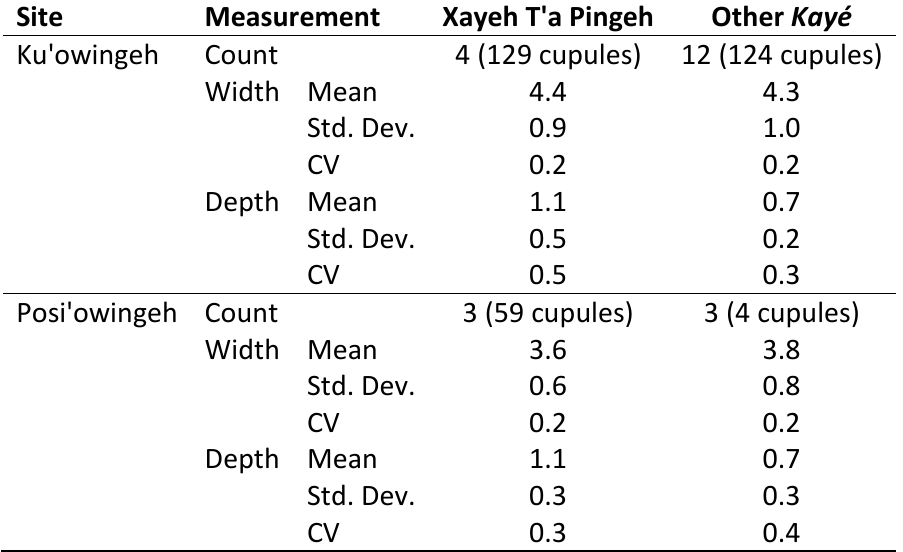
Figure 7. A Xayeh T’a Pingeh (Kayé 8) with cupules and a mortar at Ku’owingeh. Table 5. Measurements of width and depth between Xayeh T’a Pingeh and other kayé at Ku’owingeh and